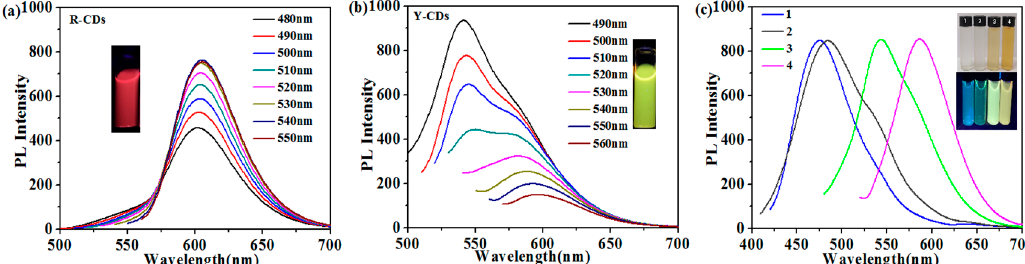
Figure 4. ( a ) Fluorescence spectra of R-CDs under di ff erent excitations. ( b ) Fluorescence spectra of Y-CDs under di ff erent excitations. The insets are photographs under 365 nm UV lamps. ( c ) Y-CDs fluorescence spectra of four samples obtained by separation. The insets are photographs of the samples under ambient light and 365 nm UV lamps.